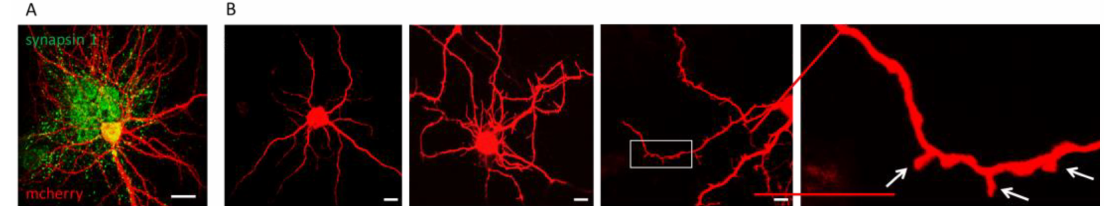
Figure 4. Reprogrammed iSNs form dendritic spines in co-cultures with mouse cortical neurons. ( A ) Representative image of iSN in co-culture with mouse cortical neurons on 14 DIV. iMSNs after the end of the reprogramming procedure were infected with lenti-mcherry. Immunofluorescent staining of co-culture with antibodies to the neuronal marker synapsin 1 (secondary antibodies conjugated with the Alexa 488 fluorophore). Confocal microscopy, × 60. The scale bar corresponds to 10 µ m. ( B ) Representative image of reprogrammed iSN infected with lenti-mcherry in the absence of cortical neurons (0 DIV) and in co-culture with mouse cortical neurons at 7 and 10 DIV. White arrows indicate the places of dendritic spine formation. Confocal microscopy, × 60. Scale bar corresponds to 10 µ